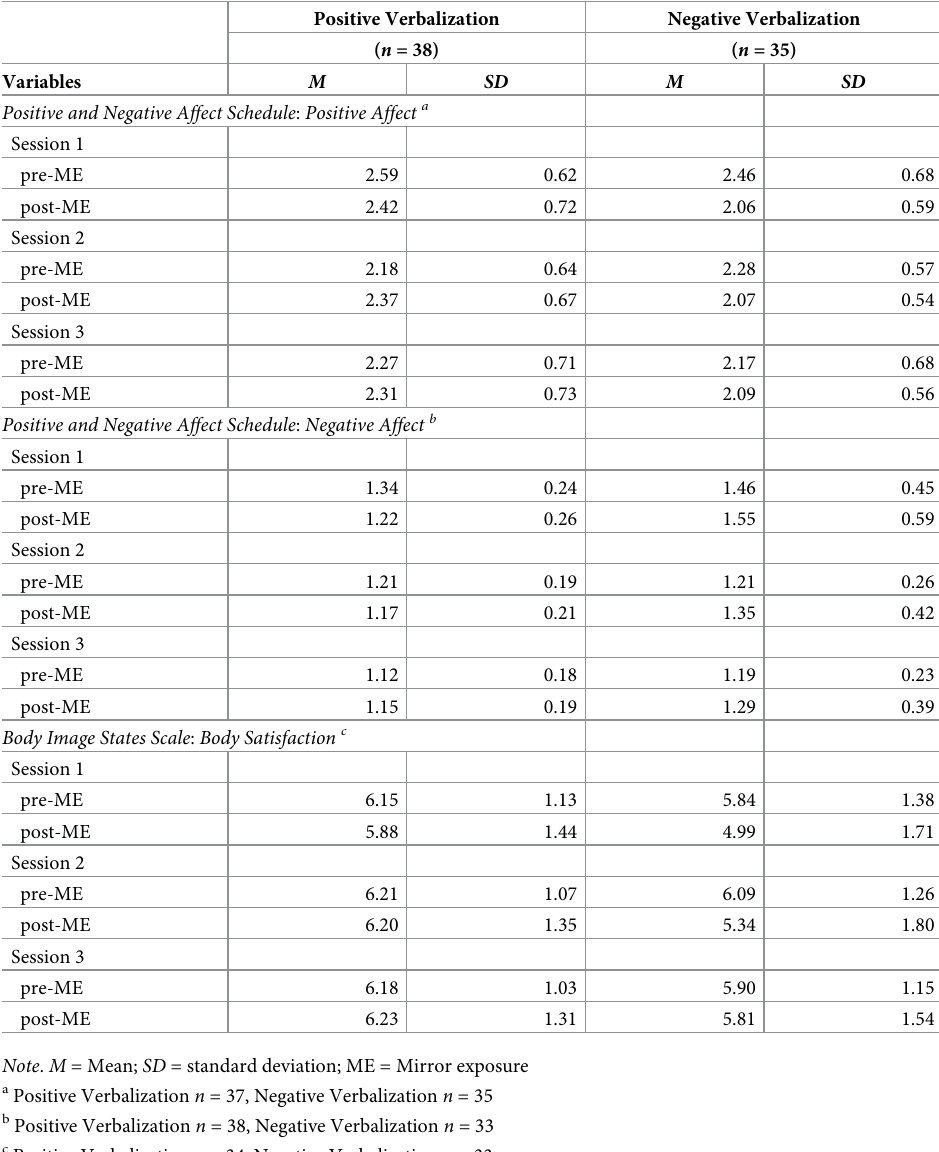
Table 2. Means and standard deviations for positive affect, negative affect and body satisfaction depending on the instructed verbalization. Positive Verbalization Negative Verbalization ( n = 38) ( n =